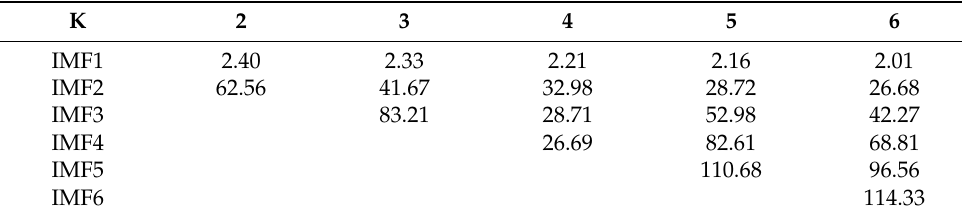
Table 2. Center frequency of each IMF component (unit: Hz). K